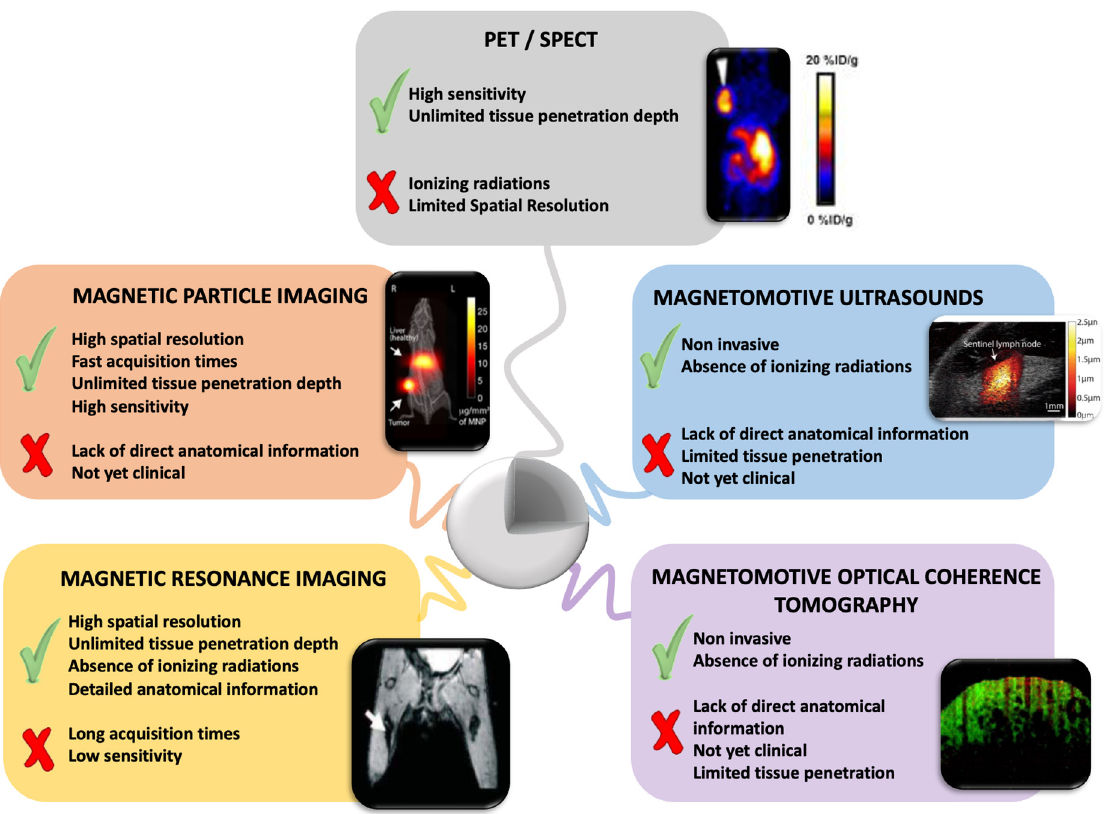
Figure 10. Advantages and limitations of the imaging techniques for tracking of MCs. MCs can be tracked by various imaging techniques (PET/SPECT; magnetic particle imaging, magnetomotive ultrasounds, magnetic resonance imaging, and magnetomotive optical coherence tomography). The selection of a precise technique is based on the assessment of the associated advantages and disadvantages. Adapted with permission from Refs. [364–368].